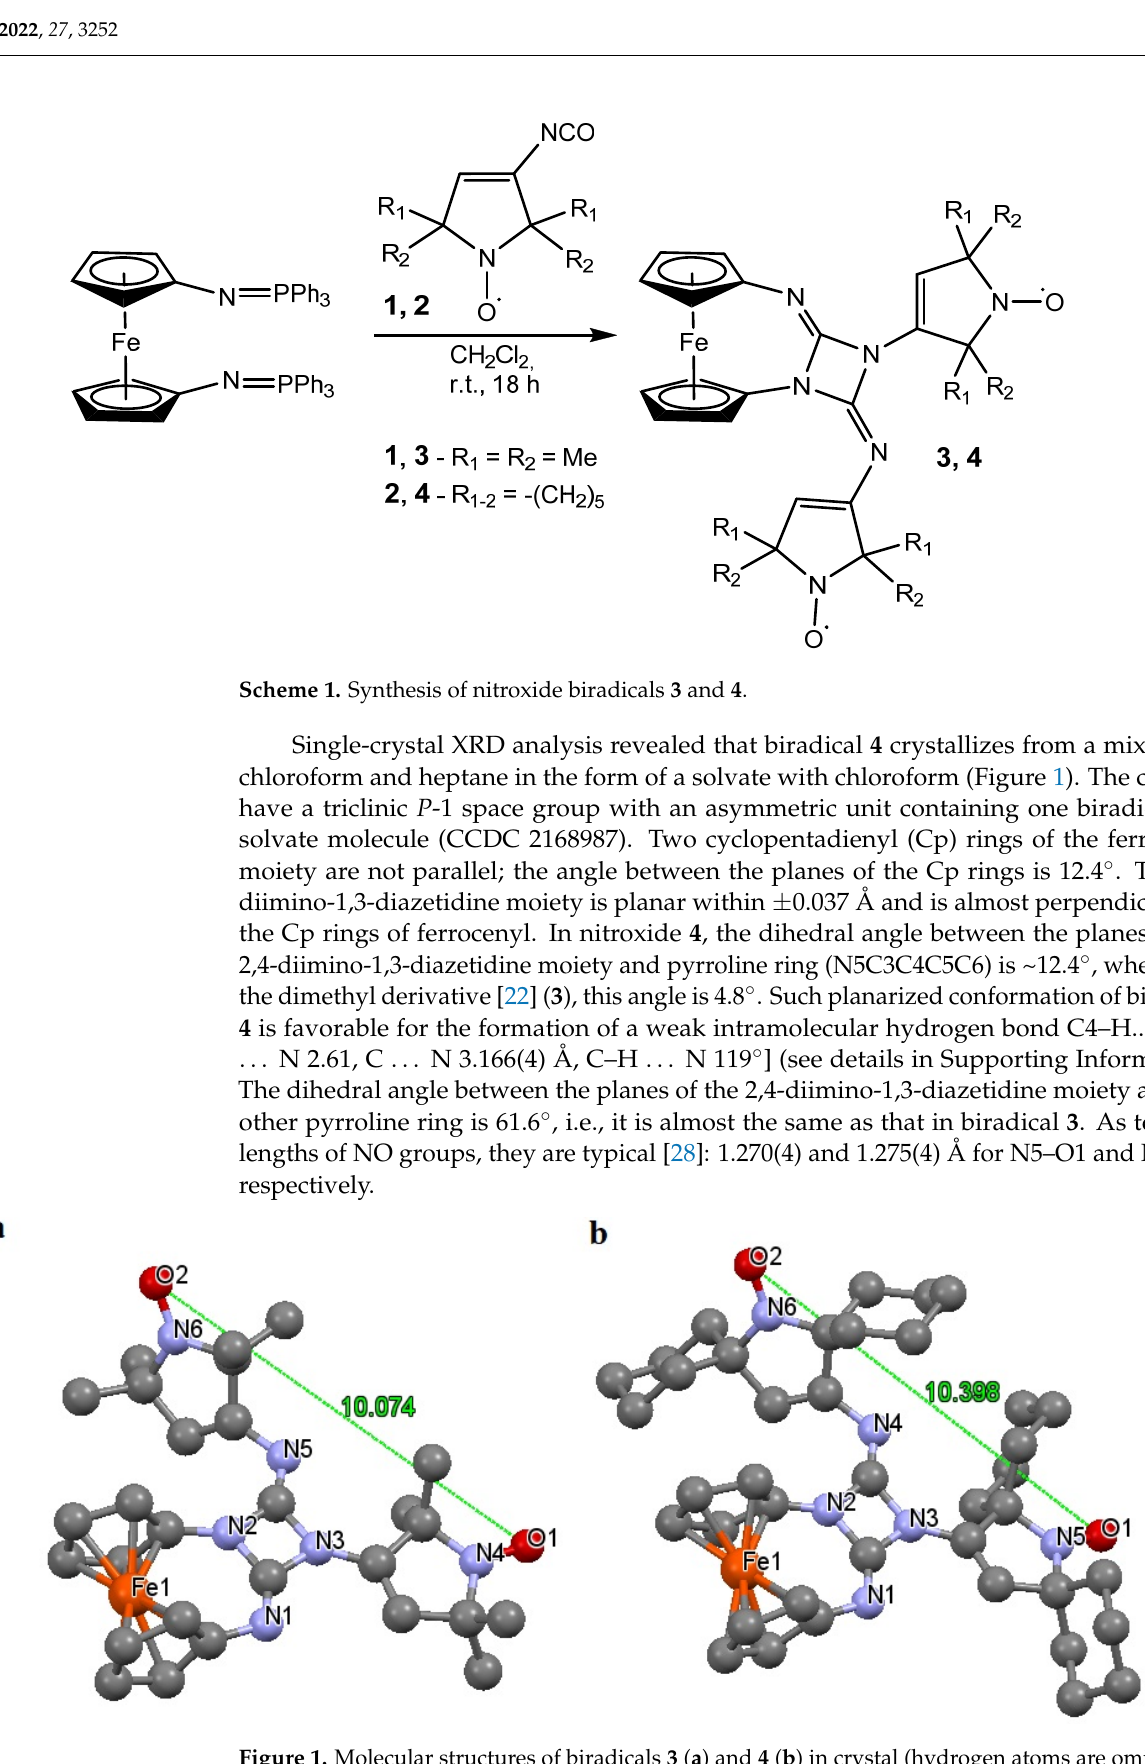
Figure 1. Molecular structures of biradicals 3 ( a ) and 4 ( b ) in crystal (hydrogen atoms are omitted for clarity). Distances (Angstrom, Å ) between radical centers are shown.